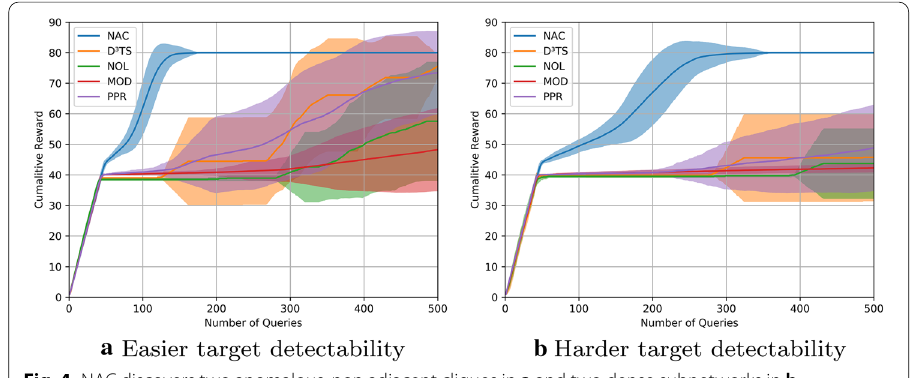
Fig. 4 NAC discovers two anomalous, non adjacent cliques in a and two dense subnetworks in b . Confidence intervals are generated by testing NAC’s performance on 200 background network instances generated using 5 different models from Table 2. We move the location of the two foreground subnetworks around, but maintain their relative distance of 2–3